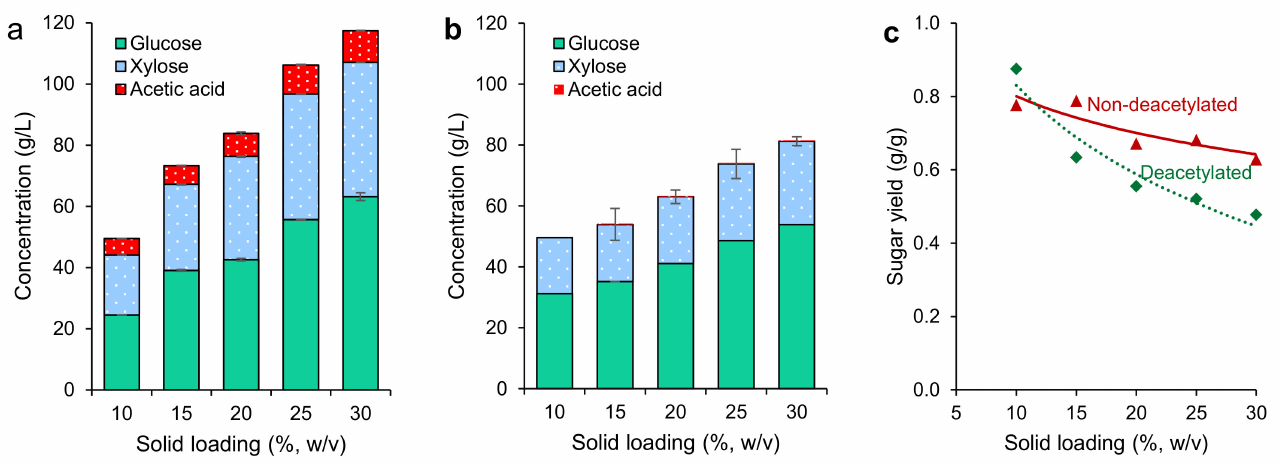
Figure 6. Effect of deacetylation at different solid loadings post-enzymatic hydrolysis ( a ) non- deacetylated oil palm trunk (OPT), ( b ) deacetylated OPT, and ( c ) sugar yield of non-deacetylated and deacetylated